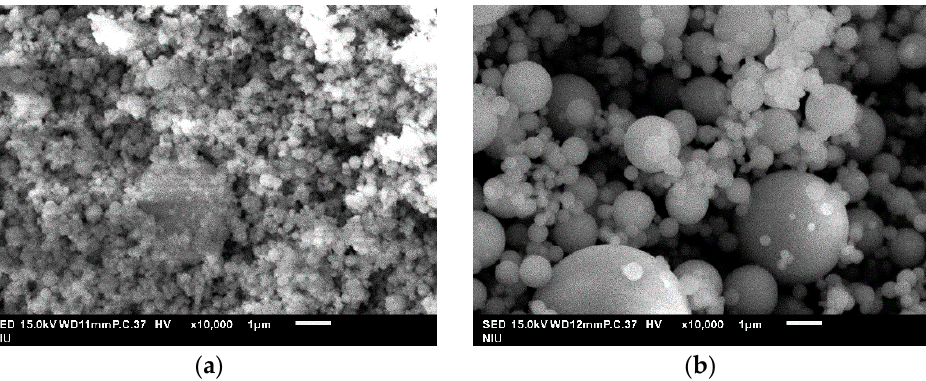
Figure 3. SEM photos (10,000× magnification): ( a ) silica fume; ( b ) RUFA.